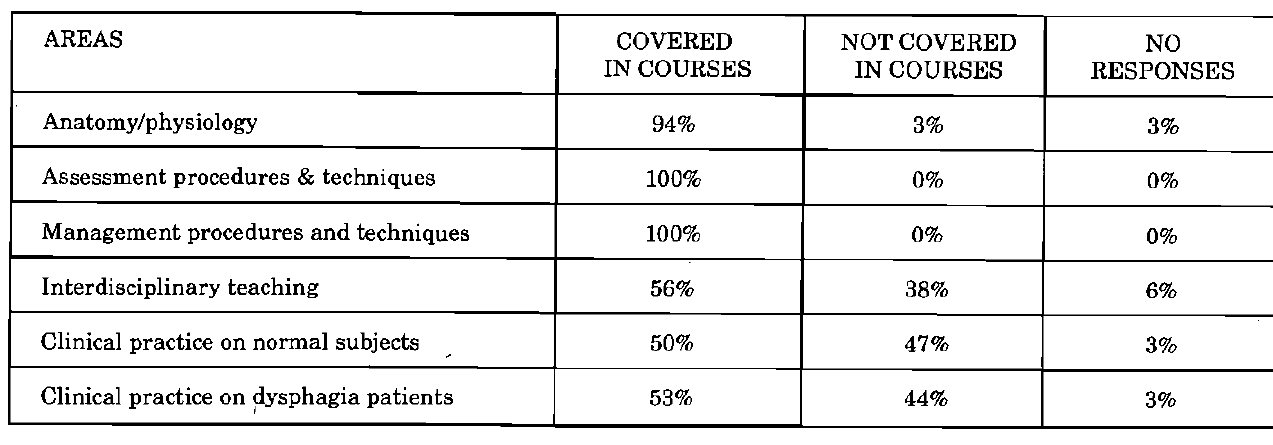
TABLE 5. Content of postgraduate courses in dysphagia (N=38)